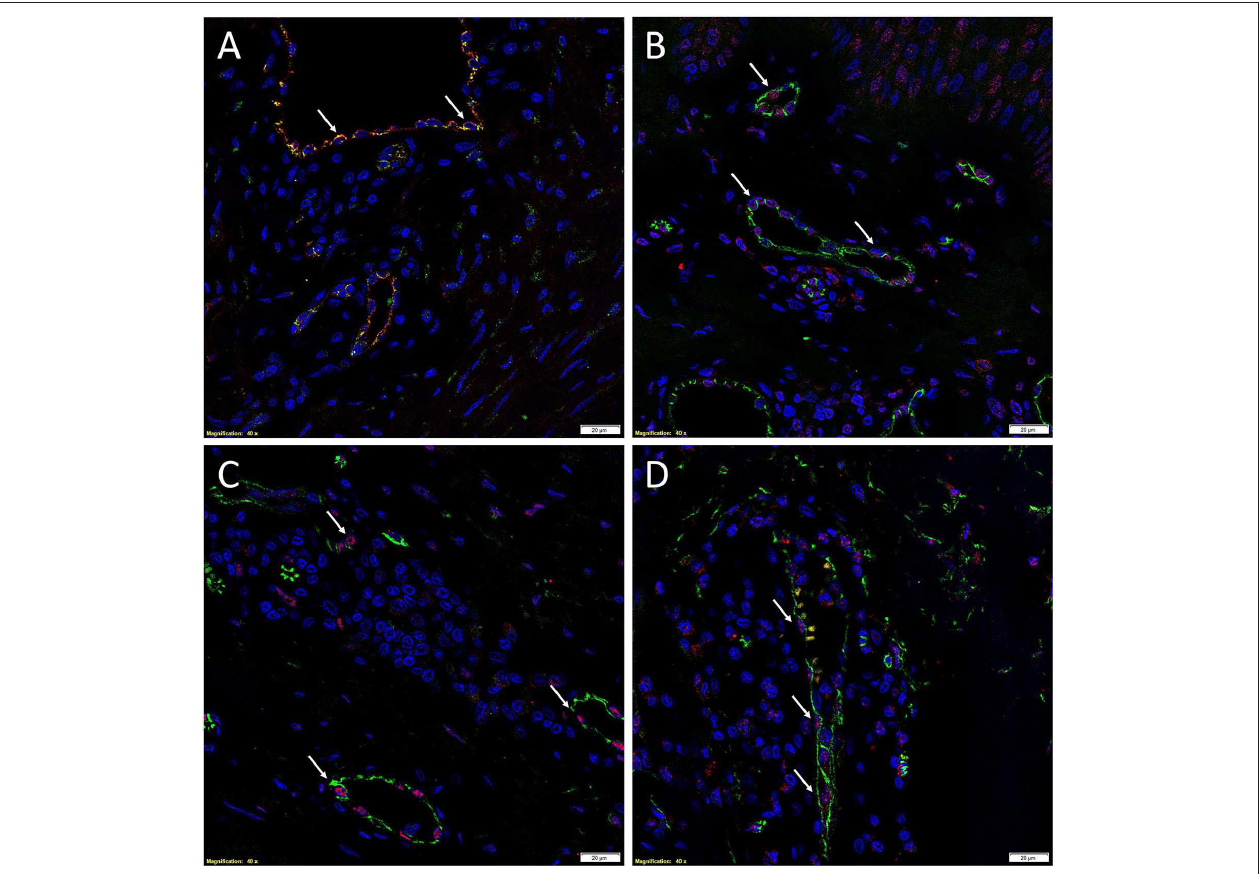
FIGURE 3 | Immunofluorescence images of representative keloid tissue sections demonstrating the expression of OCT4 ( A , green, white arrows ) on the endothelium expressing von Willebrand factor ( A , red). The co-expression of both proteins on the same cells was portrayed as orange (A) . The same endothelium, highlighted by the expression of CD34 ( B–D , green), also expressed SOX2 ( B , red, white arrows ), pSTAT3 ( C , red, white arrows ), and NANOG ( D , red, white arrows ). Cell nuclei were counterstained with DAPI. Original magnification: 400X. Reproduced with permission from the Journal of Clinical Pathology